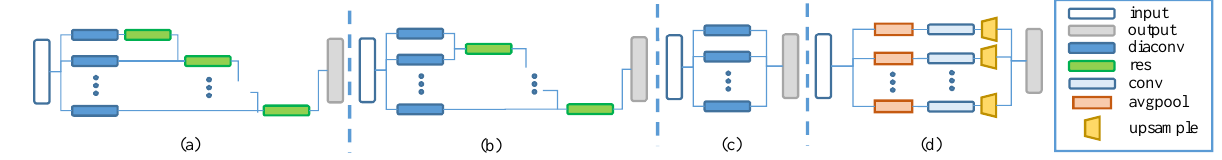
Figure 3. Different structures of multi-scale context modules. ( a ) Multi-scale context aggregation module (MSCA) w/o channel attention (CA); ( b ) cascade context pyramid module (CCPM); ( c ) scale pyramid module (SPM); and ( d ) scale-aware context module